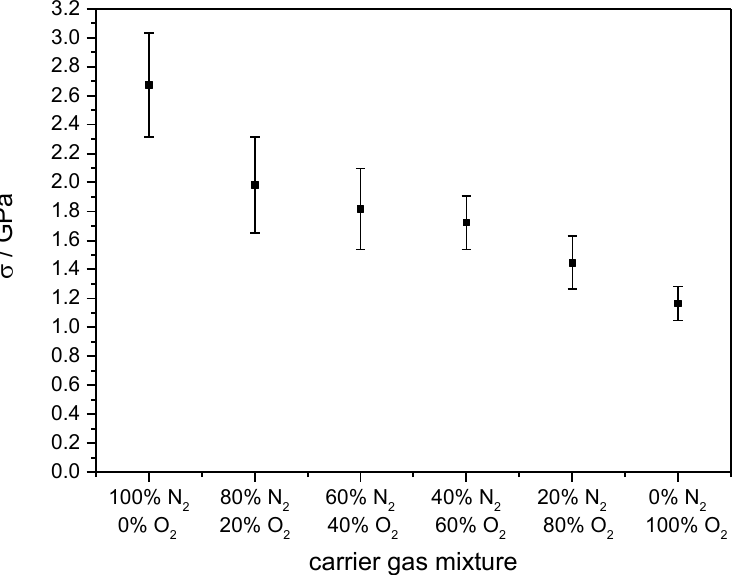
Figure 5. Film stress in dependence of N the calculation of errors of the used measurement devices.